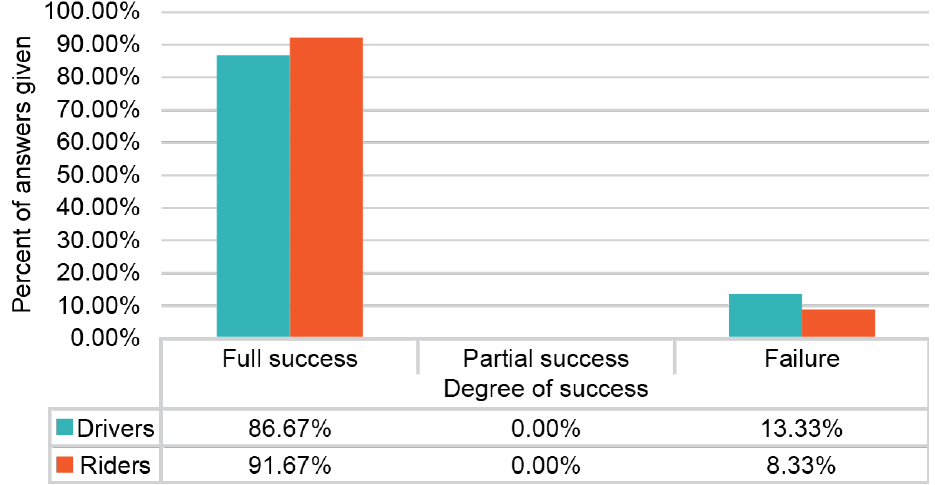
Appl. Sci. 2022 , 12 , x FOR PEER REVIEW Figure 15. Degree of success for the scenario “ VMS ” . Figure 15. Degree of success for the scenario “VMS”.